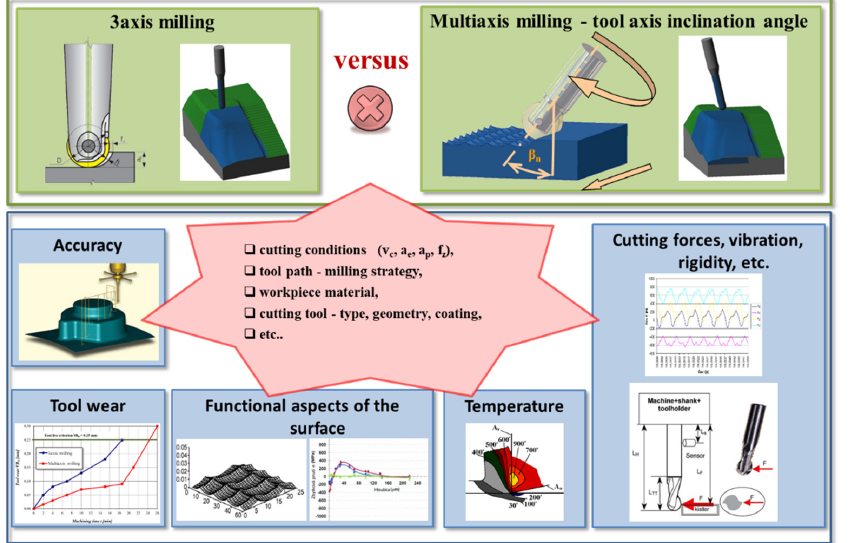
Figure 1. Aspects of the machining process.